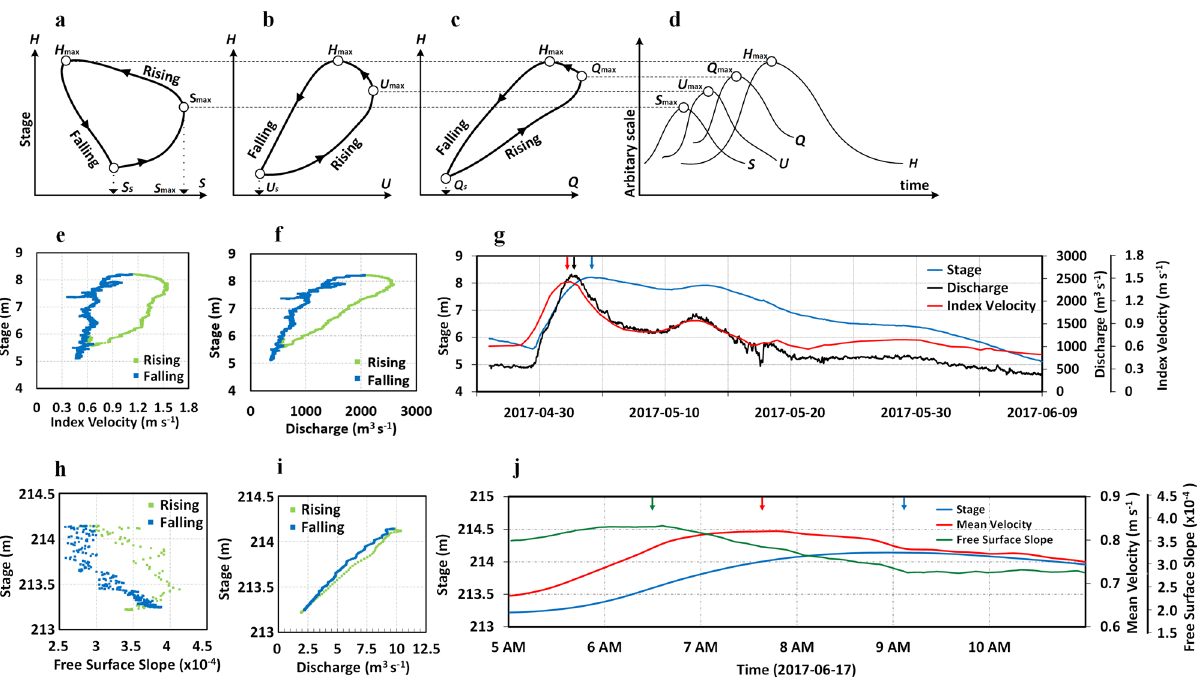
Fig. 1 Hysteresis effects on fl ow variables. a Stage vs. free-surface water slope 4 . b Stage vs. index velocity 19 . c Stage vs. discharge 4 . d Hydrograph phase sequencing 4 . e – g Relationships for pairs of variables measured during a fl ood wave propagating through USGS #05558300 index-velocity station. See Supplementary Data 1 to generate related charts. h – j Relationships for pairs of variables measured with the CSA method during a fl ood wave propagating at USGS #05454220 18 . Rising and falling terms in the plots specify stage variation phases (i.e., from steady fl ow to H max ). See Supplementary Data